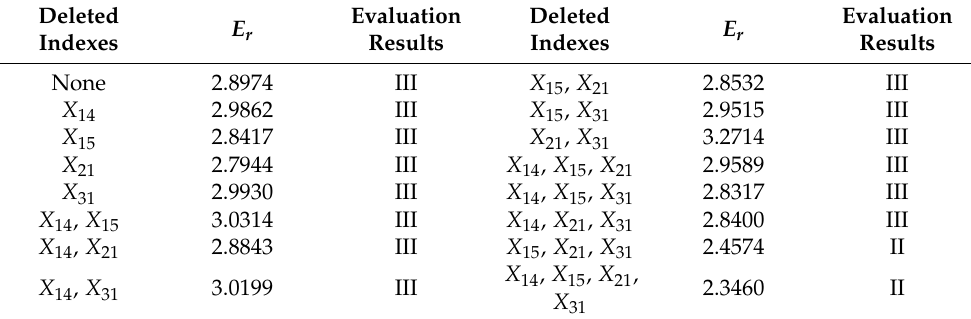
Table 6. Influence of different evaluation index systems on evaluation